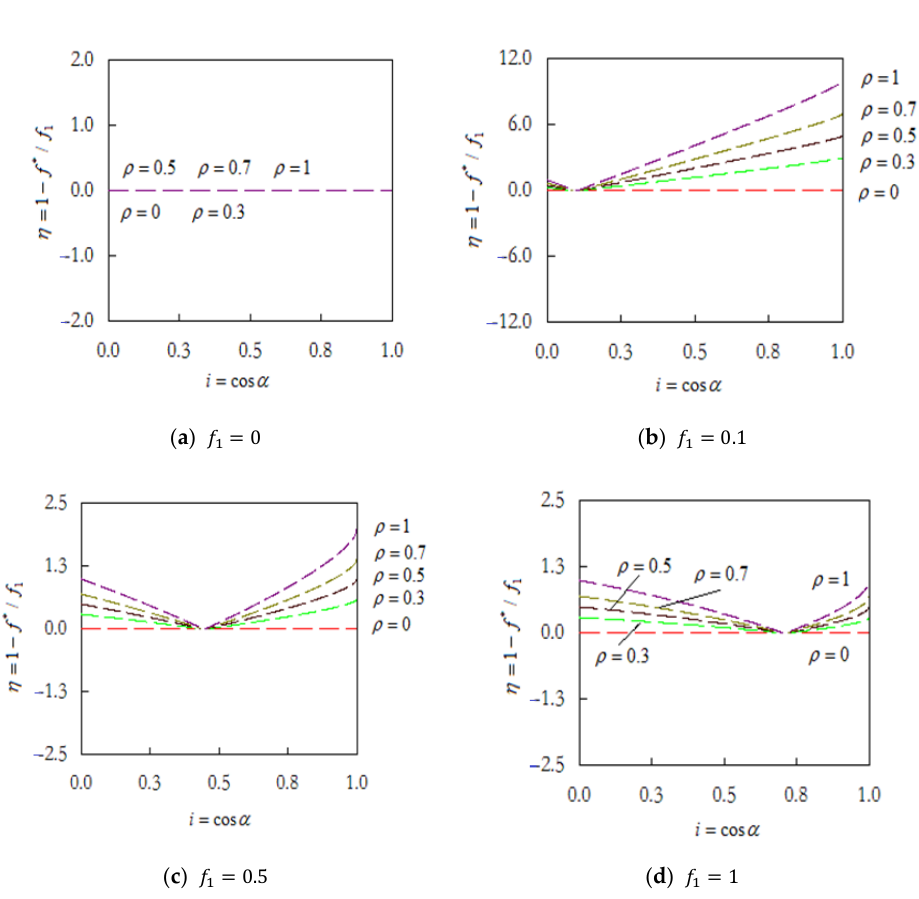
Figure 8. The negative gradient of effective friction coefficient 𝜂 .